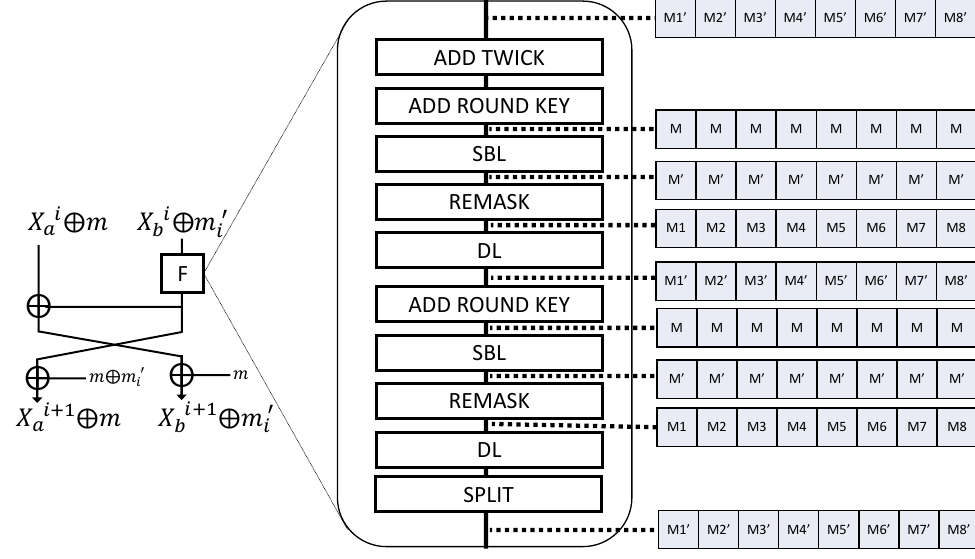
Figure 6. Proposed masking